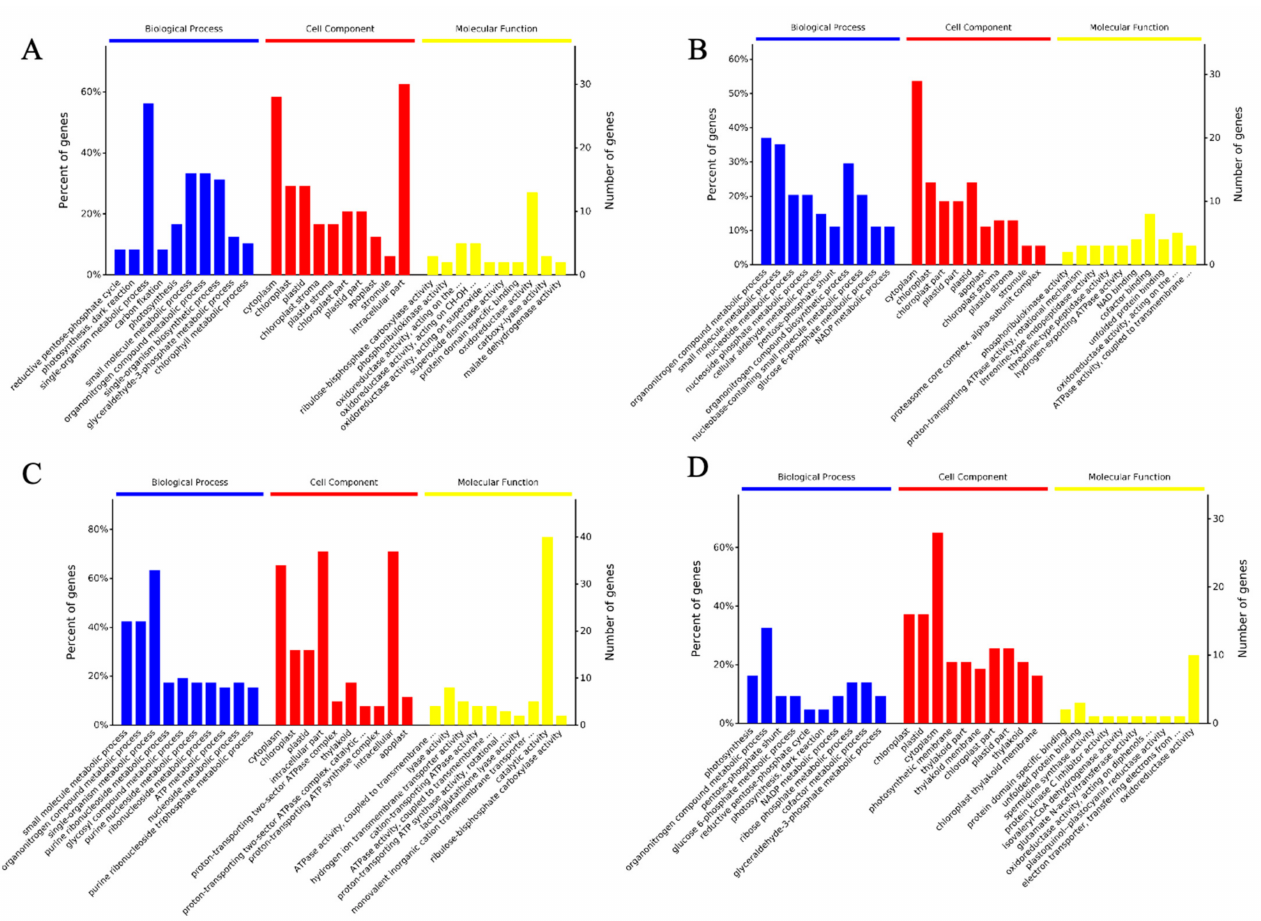
Figure 4. GO annotation of four groups of proteins in three categories: biological process (BP), cellular component (CC), and molecular function (MF). The figures show total percentage of genes assigned to three categories of enrichment analysis of the top ten entries according to the significant degree: biological processes (blue), cell component (red), and molecular function (yellow). From left to right is under the − log ( p -value) from a large to a small array, which means that the closer to the left side, the more significant. The vertical axis represents the number and proportion of proteins or genes in each entry. ( A ) M-M, ( B ) M-SA, ( C ) R-M, ( D )